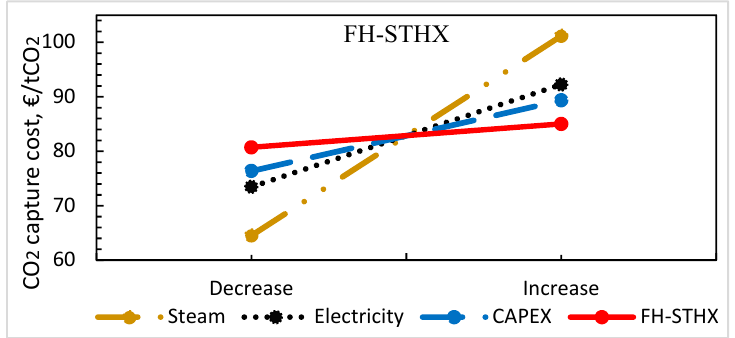
Figure 11. Sensitivity of important economic variables on the capture cost of the FH-STHX case.